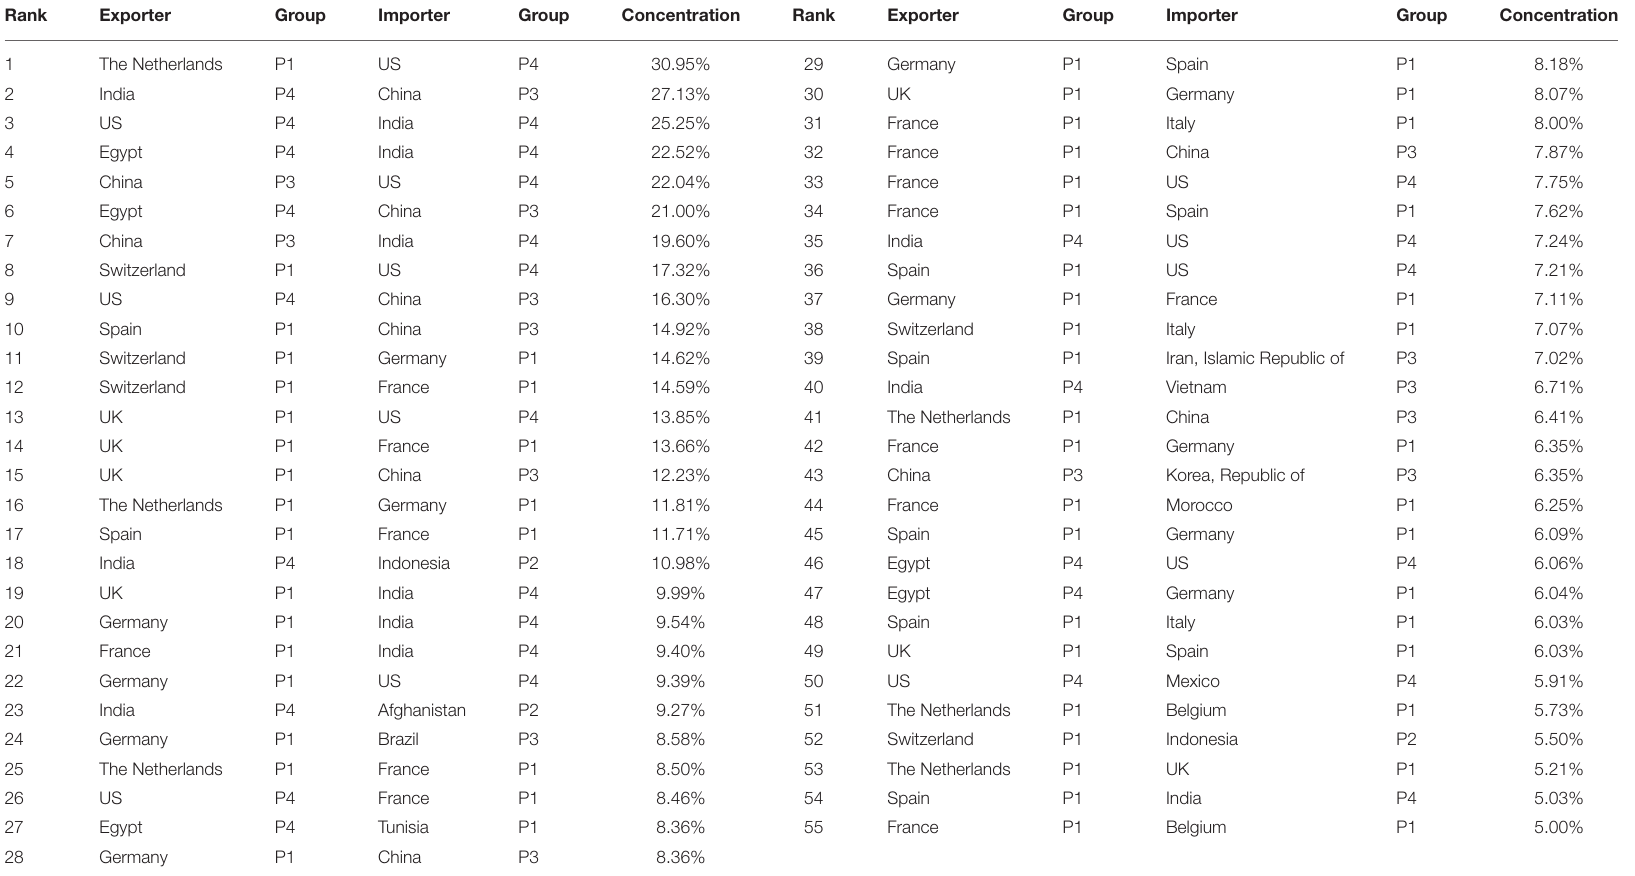
TABLE 3 | Co-opetition between major importers of TCM products in 2020 a